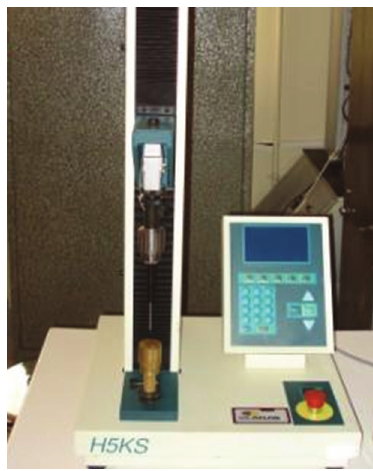
Figure 2: Universal test machine used in the compression